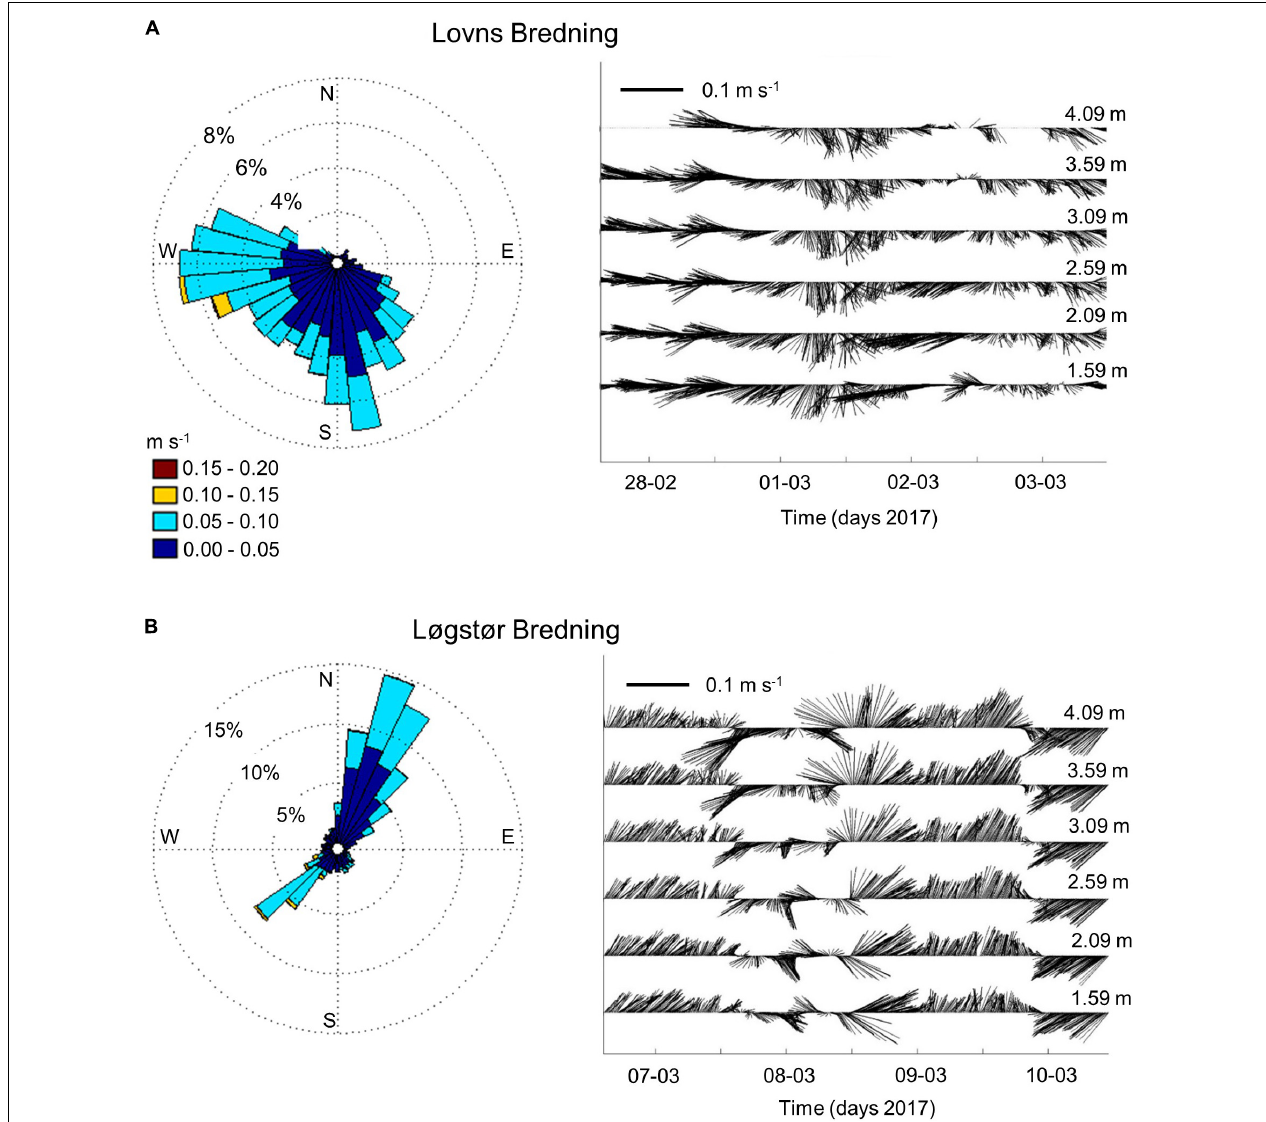
FIGURE 3 | Rose plots of instantaneous currents at all depths (left column) and corresponding time series of instantaneous currents (every 20th data point is shown corresponding to 10 min intervals) at different depth layers (right column) measured by the ADCP at (A) Lovns Bredning and (B) Løgstør